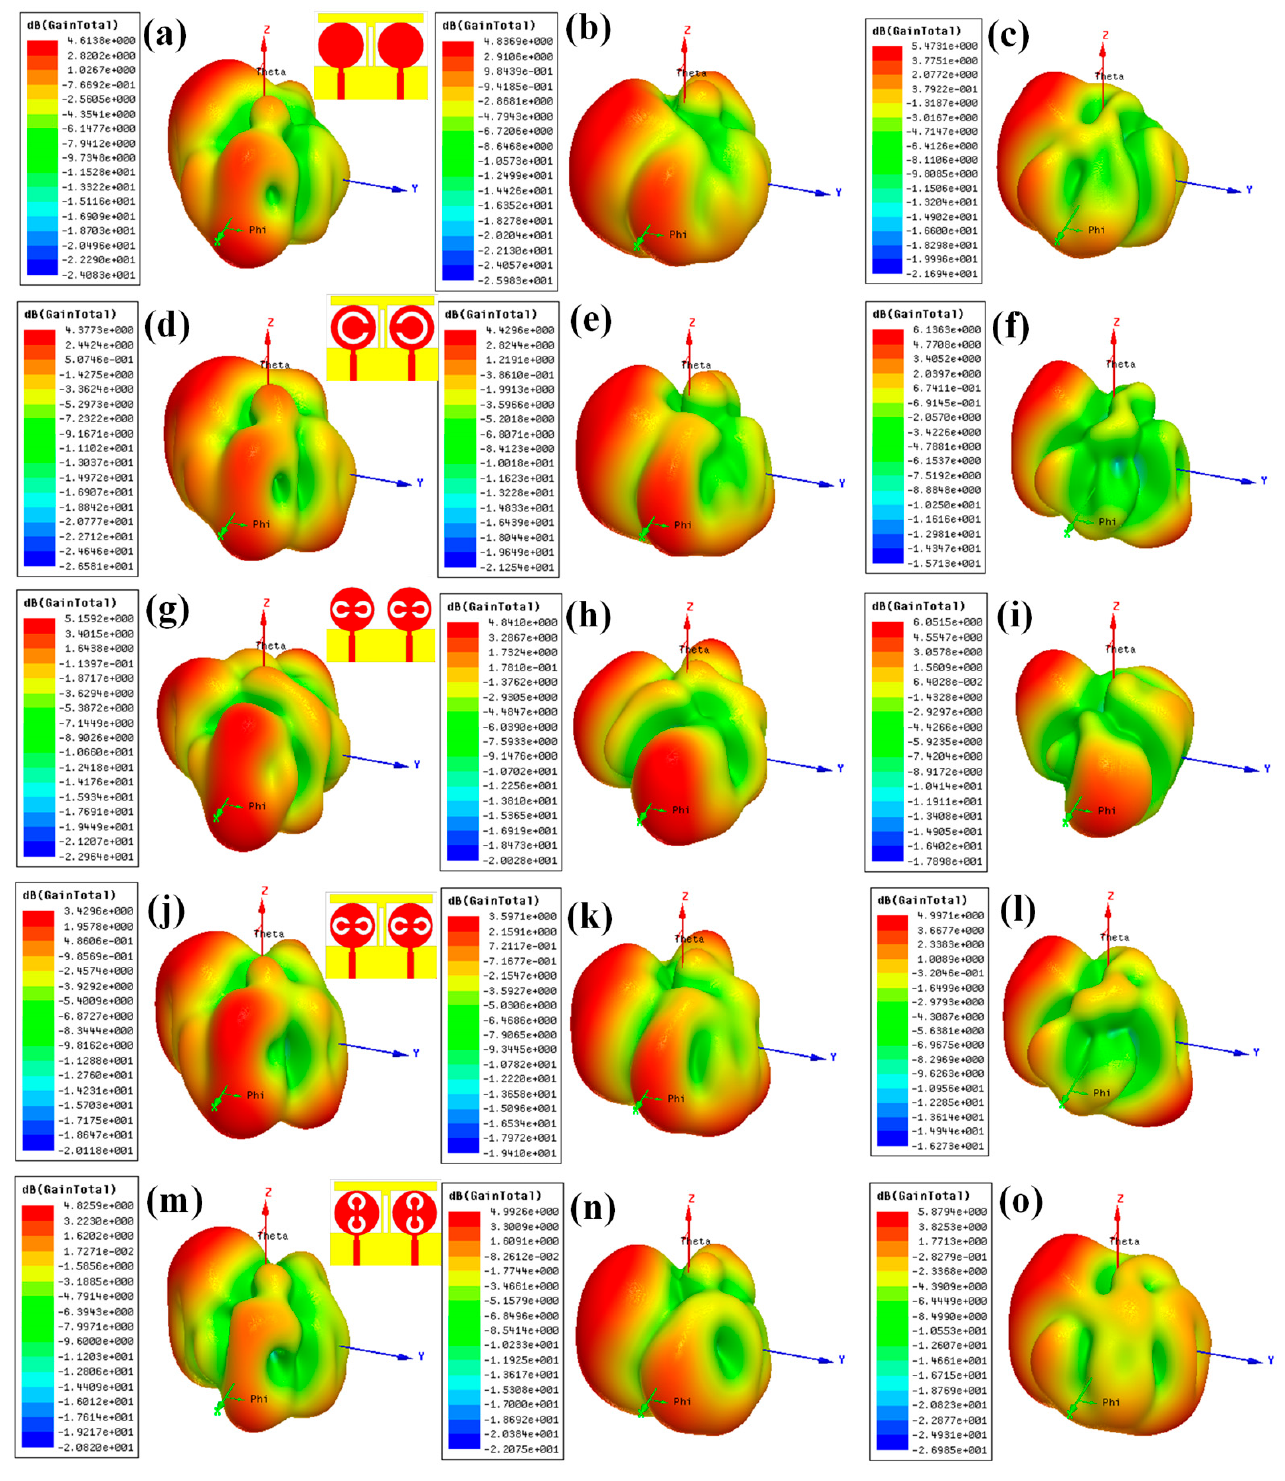
Figure 4. Variation in the radiation in 3D polar plots for the different port excitation conditions of ( a – c ) design 1, ( d – f ) design 2, ( g – i ) design 3, ( j – l ) design 4, and ( m – o ) design 5 antenna. The different port excitation conditions are ( a , d , g , j , m ) P 1 = 0 and P 2 = 1, ( b , e , h , k , n ) P 1 = 1 and P 2 = 0, and ( c , f , i , l , o ) P 1 = 1 and P 2 = 1.